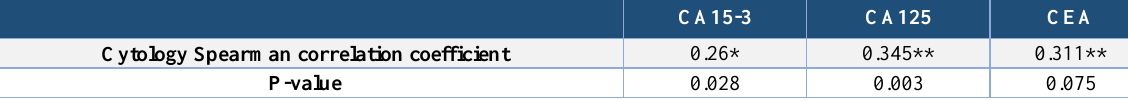
Table 3 . Correlation coefficients and relationships between tumor markers with cytomorphological results.